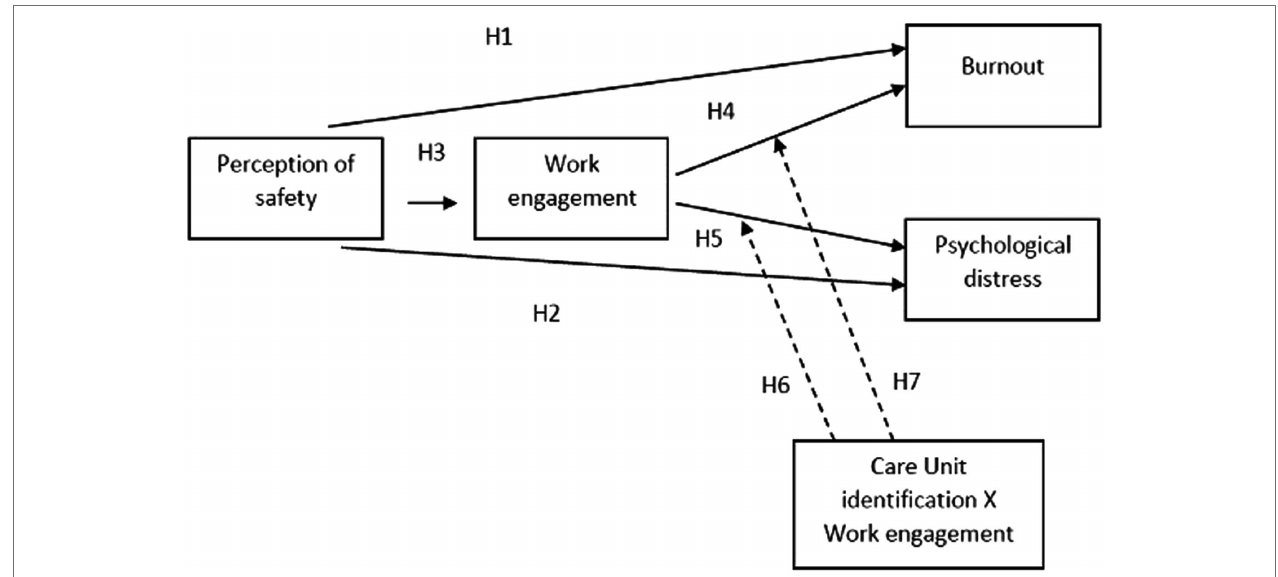
FIGURE 1 | The hypothesized model. Solid lines represent supposed direct and mediational effects. Dashed lines represent the hypothetical moderation effects of CU identification on relationship of Work engagement and negative outcomes (Burnout and Psychological